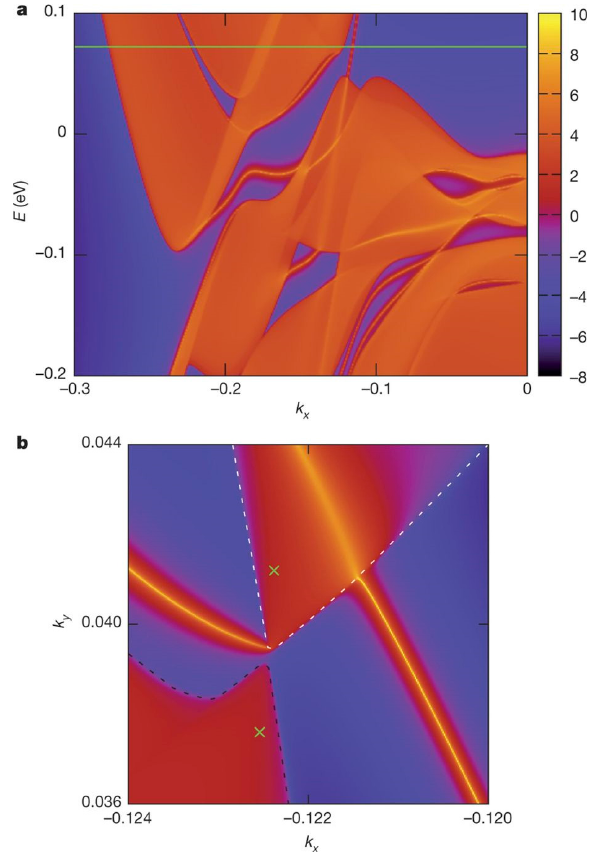
Figure 3. ( a ) The position of the Fermi level (green line); ( b ) The position of Weyl points (WPs) and Fermi arc on the Fermi surface [12]. Fermi arc on the Fermi surface